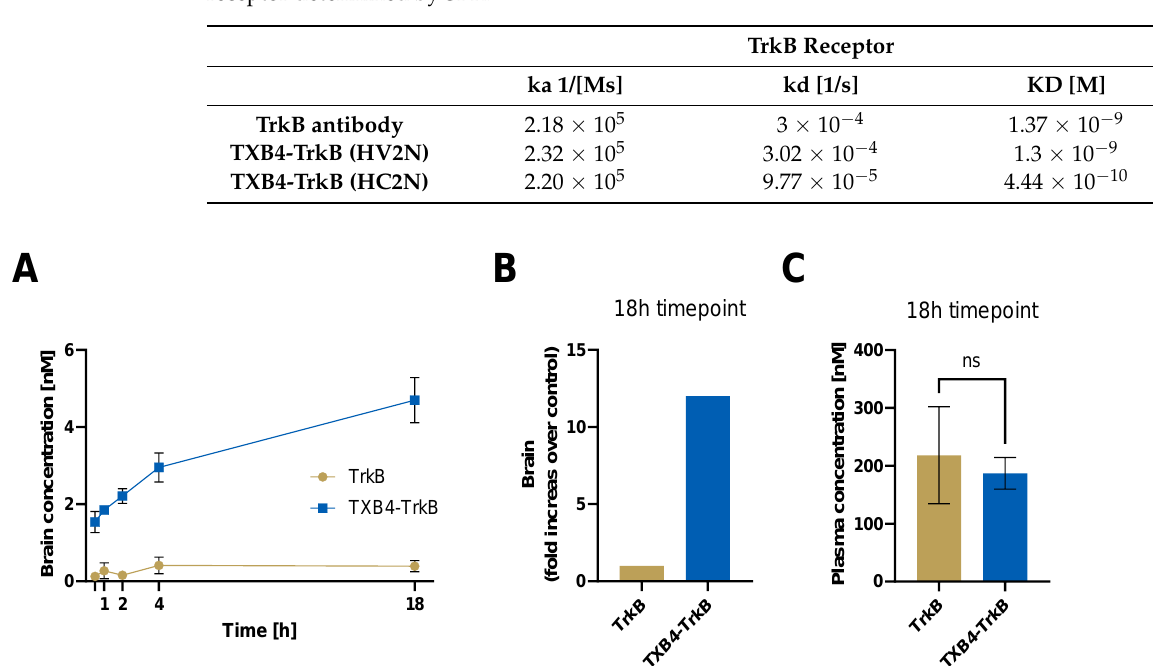
Table 2. Binding kinetics of the TrkB antibody and bivalent TXB4-antibody fusions to the TrkB receptor determined by SPR.